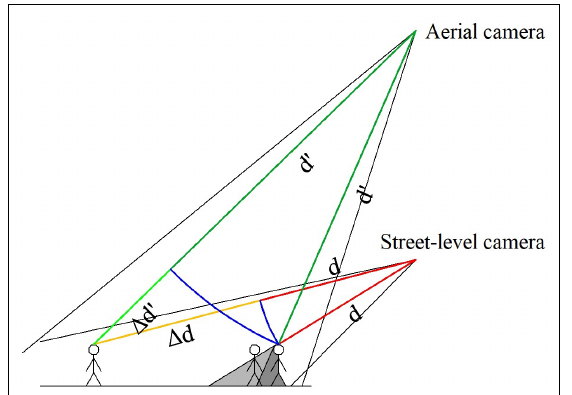
Figure 3. Illustration of differences between street-level and aerial footage. ( d + ∆ d ) / d is much further from 1.0 than ( d (cid:48) + ∆ d (cid:48) ) / d (cid:48) . Moreover, the dark gray area is obstructed from both cameras, whereas the light gray area is only obstructed from the street-level camera. Note that the image is not to